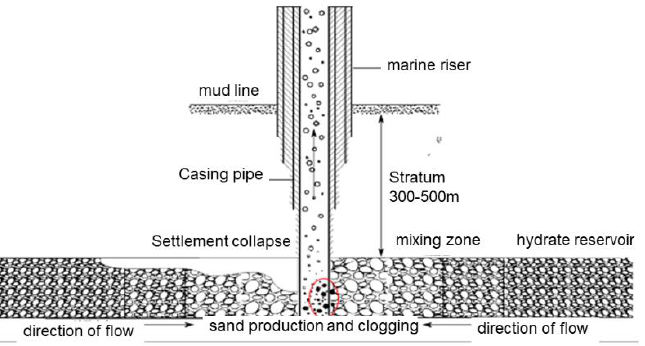
Figure 3. Several typical wellbore integrity failure modes in hydrate production: reservoir subsidence, collapse, and sand production plugging [This figure was modified with permission from ref. [15]. Copyright 2019, Elsevier].